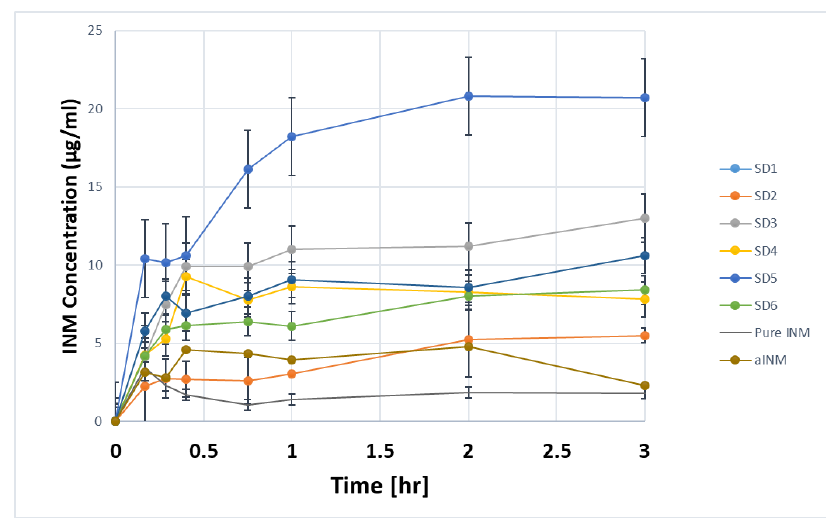
Figure 12. In-vitro dissolution profiles of quaternary SD formulations performed in buffer of pH 1.2. The maximum aqueous solubility is 20.73 µg/mL after 3 h. (AC = Air cooled, NT = Normal room temperature and Liq N 2 = Liquid Nitrogen).